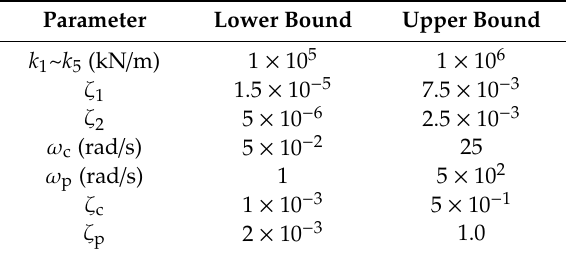
Table 8. Bounds of the prior uniform distributions for the parameters of the nonlinear structural system. Parameter Lower Bound Upper Bound